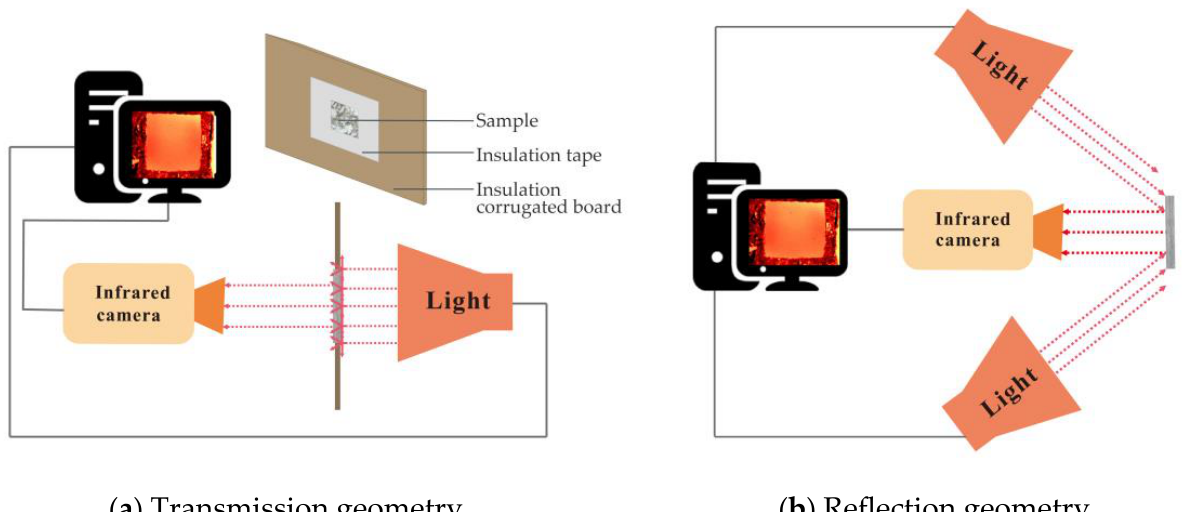
Figure 8. Experimental setups for ( a ) transmission and ( b ) reflection IRT measurements.